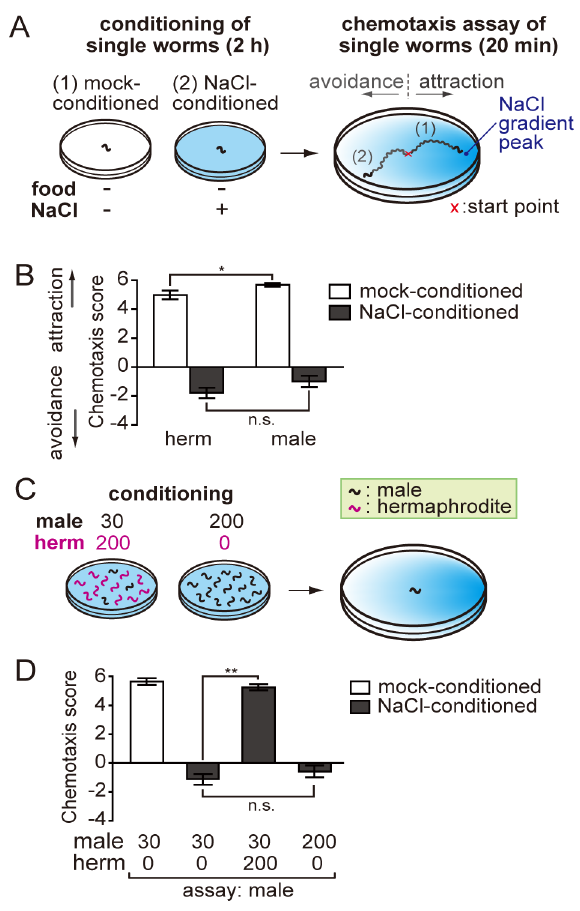
Figure 1. Sexual conditioning of salt chemotaxis behavior in the male. (A) Schematic of the assay for single worms in starvation- dependent plasticity of chemotaxis. Each worm was separately conditioned in the absence (1) or presence (2) of NaCl and tested for salt chemotaxis. Representative traces of (1) attraction to and (2) repulsion from the salt-concentration peak are shown. (B) Plasticity of salt chemotaxis in hermaphrodites (herm) and males. Single animals were subjected to starvation conditioning in the presence (NaCl- conditioned) or absence (mock-conditioned) of salt. No significant difference between males and females was observed in this paradigm. (C) Procedures to examine inter-sexual and inter-individual effects during salt/starvation conditioning of males. (D) Males are sexually conditioned to be attracted to salt after conditioning with hermaph- rodites (herm), and this effect is not observed when conditioned with males. **, P , 0.001; *, P , 0.01; n.s., not significant. Error bars represent SEM. n=55–80 animals for each